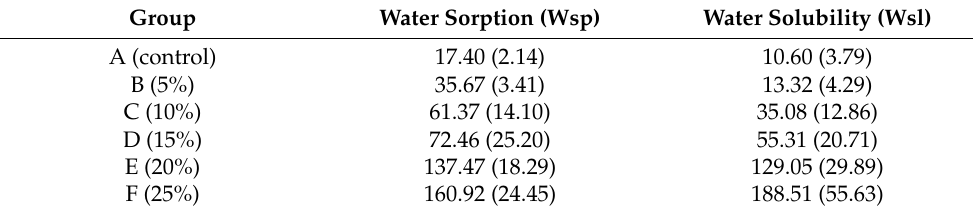
Figure 3. Water sorption and water solubility for self-cure PMMA with various Gantrez concentrations ( n = 12). Note: the letter a represents the absence of a statistically significant difference between the mean of the sample group compared to the water sorption control ( p > 0.05). The letter b indicates that there is no statistically significant difference between the mean of the sample groups compared to the water solubility control ( p > 0.05).